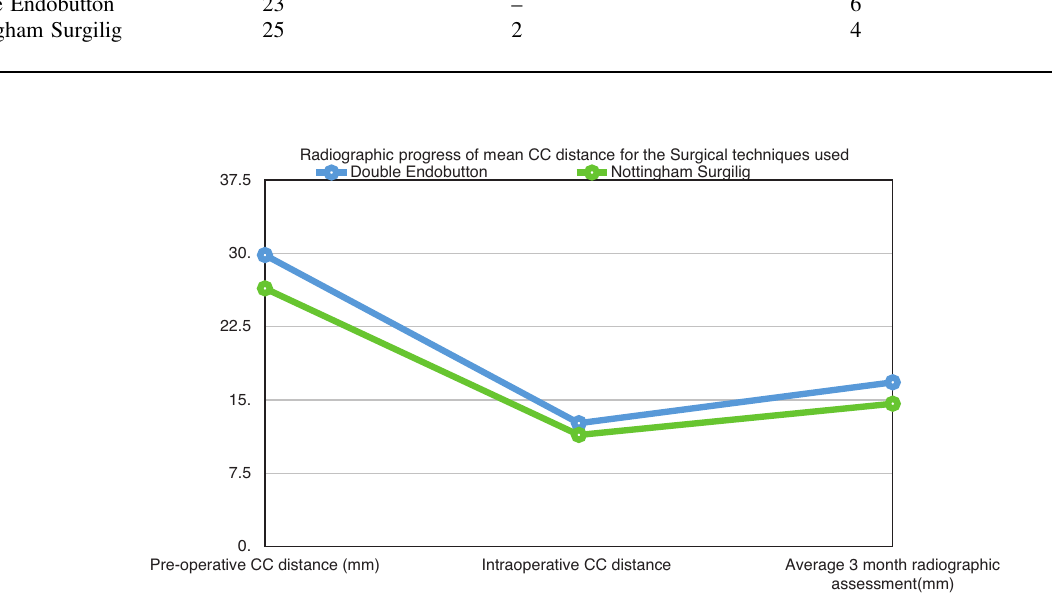
Graph 1. Radiographic progress of mean CC distance in the two techniques.